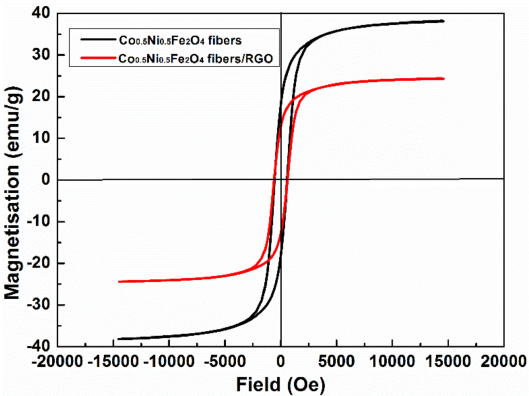
Figure 3. Magnetic hysteresis curves for Co 0.5 Ni 0.5 Fe 2 O 4 fibers and Co 0.5 Ni 0.5 Fe 2 O 4 fibers/RGO composites measured at room